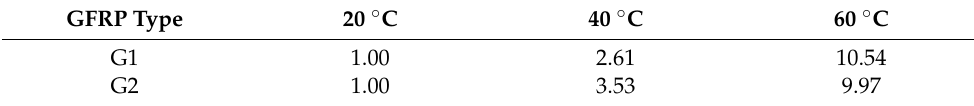
Table 8. TSF at temperatures of 20, 40, and 60 ◦ C based on the second prediction model.